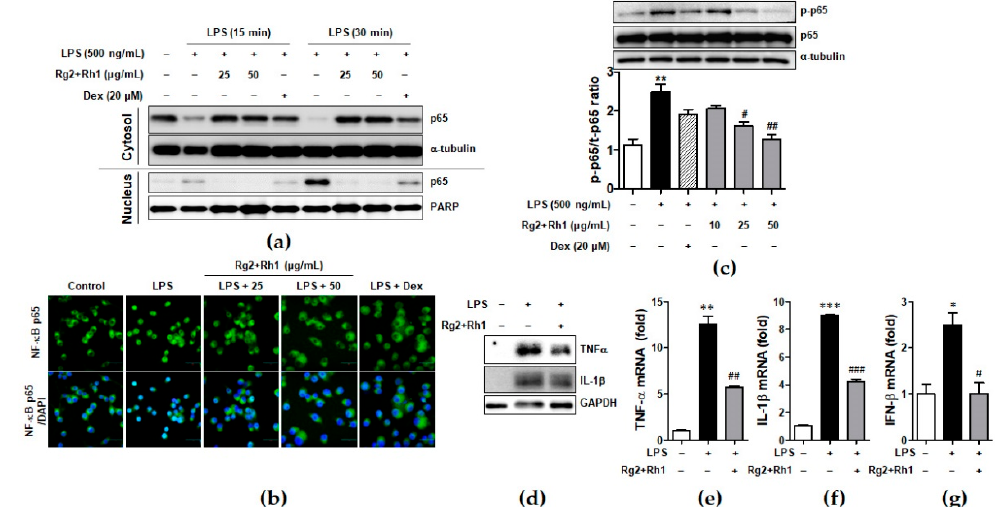
Figure 4. E ff ect of ginsenosides Rg2 and Rh1 on NF- κ B p65 nuclear translocation and activation and cytokine production. ( a ) The RAW264.7 cells were pre-treated with the combination of ginsenosides Rg2 and Rh1 (1:1 ratio) at di ff erent concentrations (25 and 50 µ g / mL) for 24 h followed by treatment with LPS (100 ng / mL) for 15 or 30 min. Cytosolic and nuclear proteins were extracted and subjected to western blotting. ( b ) The RAW264.7 cells were pre-treated with the combination of ginsenosides Rg2 and Rh1 (1:1 ratio) at di ff erent concentrations (25 and 50 µ g / mL) for 24 h followed by treatment with LPS (100 ng / mL) for 15 min. Immunofluorescence analysis was performed after fixing and immunostaining with NF- κ B p65. DAPI was co-stained for visualizing nucleus. Images are shown at × 600 magnification. Scale bar indicates 30 µ m. ( c ) The RAW264.7 cells were pre-treated with the combination of ginsenosides Rg2 and Rh1 (1:1 ratio) at various concentrations (10, 25, and 50 µ g / mL) for 1 h followed by treatment with LPS (500 ng / mL) for 3 h. Whole protein lysates were subjected to western blotting. (Lower bar graph) The ratio of phosphorylated p65 / α -tubulin expression represents as the mean ± SEM ( n = 8). ( d – g ) Peritoneal macrophages were collected from the mice that were i.p. injected with the combination of ginsenosides Rg2 and Rh1 (1:1 ratio, 20 mg / kg) for 24 h followed by treatment with LPS (10 mg / kg) for 24 h. Inhibitory e ff ects of the ginsenosides on protein expressions of TNF- α and IL-1 β were analyzed by western blotting ( d ), and mRNA levels of TNF- α ( e ), IL-1 β ( f ), and IFN- β ( g ) were analyzed by qRT-PCR. Each cytokine was normalized by glyceraldehyde 3-phosphate dehydrogenase (GAPDH) ( n = 3). Data was calculated using the 2 − ∆∆ C t method and represented as mean ± SEM ( n = 3). * p < 0.05, ** p < 0.01, and *** p < 0.001 compared with control sample, # p < 0.05, ## p < 0.01, and ### p < 0.001 compared with LPS-treated